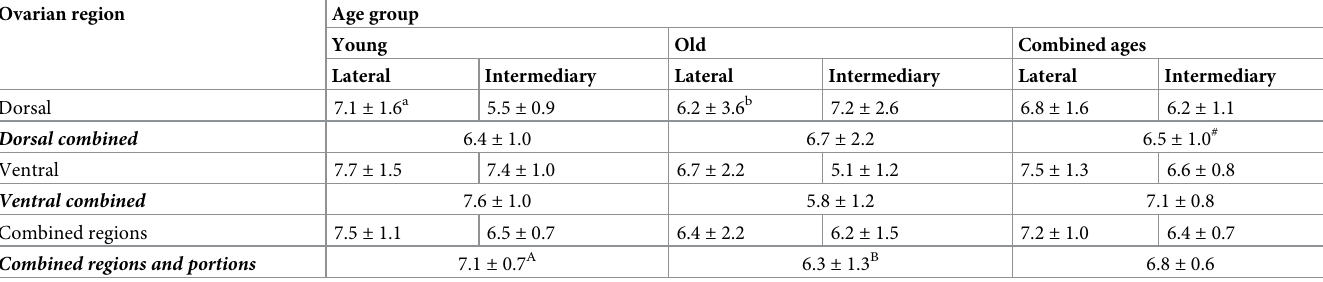
Preantral follicle clustering was evaluated using Morisita’s index of clustering (I δ ) with all indices testing positive for clustering (Z � 1.96). a,b Within the same ovarian region and portion, values without a common superscript differed ( P < 0.05). A,B Within combined ovarian regions and portions, values without a common superscript differed ( P < 0.05). # The dorsal ovarian region tended to differ ( P = 0.06) from the ventral ovarian region when ages and ovarian portions were combined. No differences ( P > 0.05) were observed between age groups within the intermediary portion and dorsal region of the ovary, within the ventral region and combined regions, or between portions when ages were combined. Data were analyzed using the Kruskal-Wallis